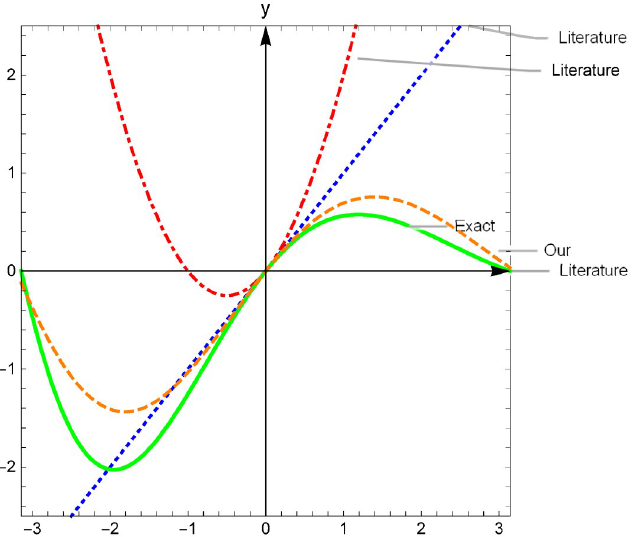
Fig 5. Comparison of the efficiencies of first term � y interval of t = 0 in Example 2.